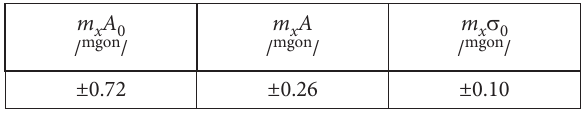
Table 11. Parameters for calculating the mean error